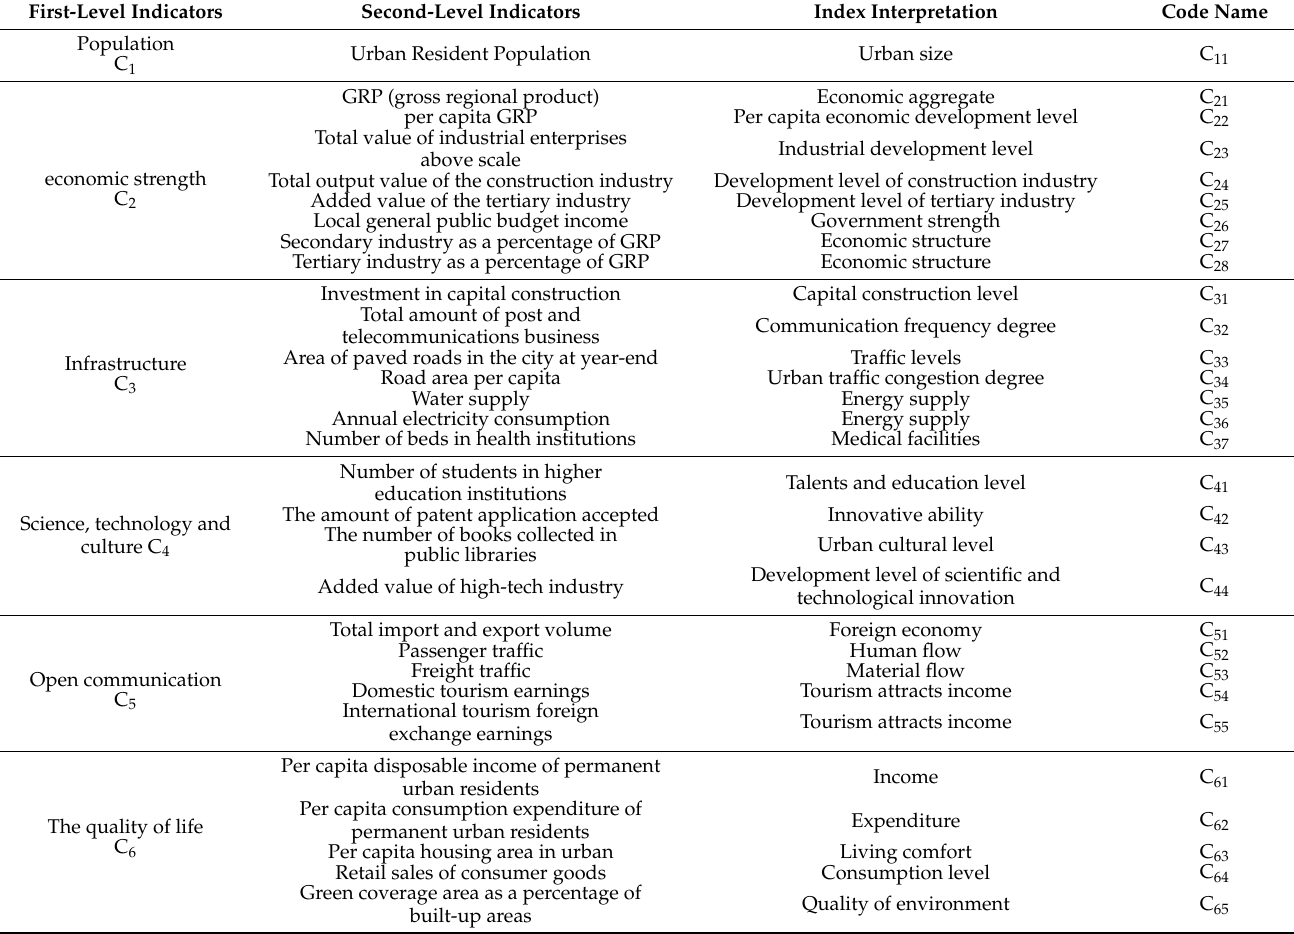
Table 1. The evaluation index system of urban